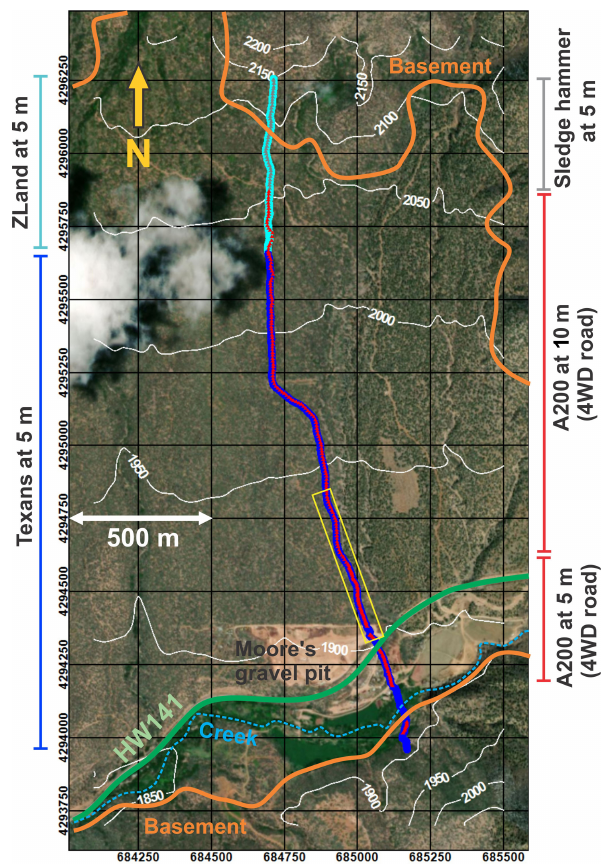
Figure 2. Geometry of the 2017 seismic acquisition. Thick blue line: Texan 1C receivers; thick cyan line: Fairfield 3C nodes; red triangles: shot locations of the A200 P&S source; grey triangles: shot locations of the sledgehammer; green line: highway 141. White lines: elevation contours in meters above sea level. Blue dashed line: West Unaweep Creek. The yellow rectangle outlines the represen- tative area for Fig.